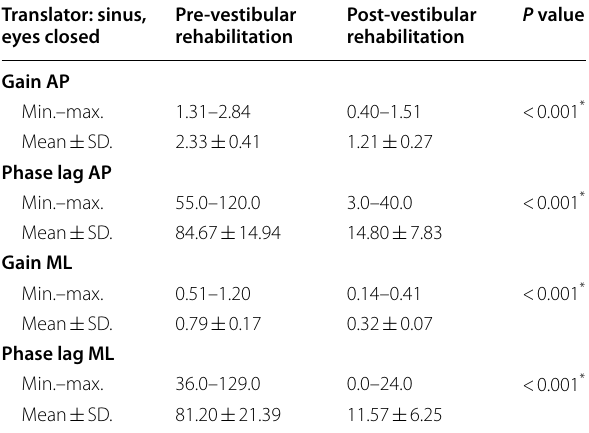
SD standard deviation *Statistically significant at p